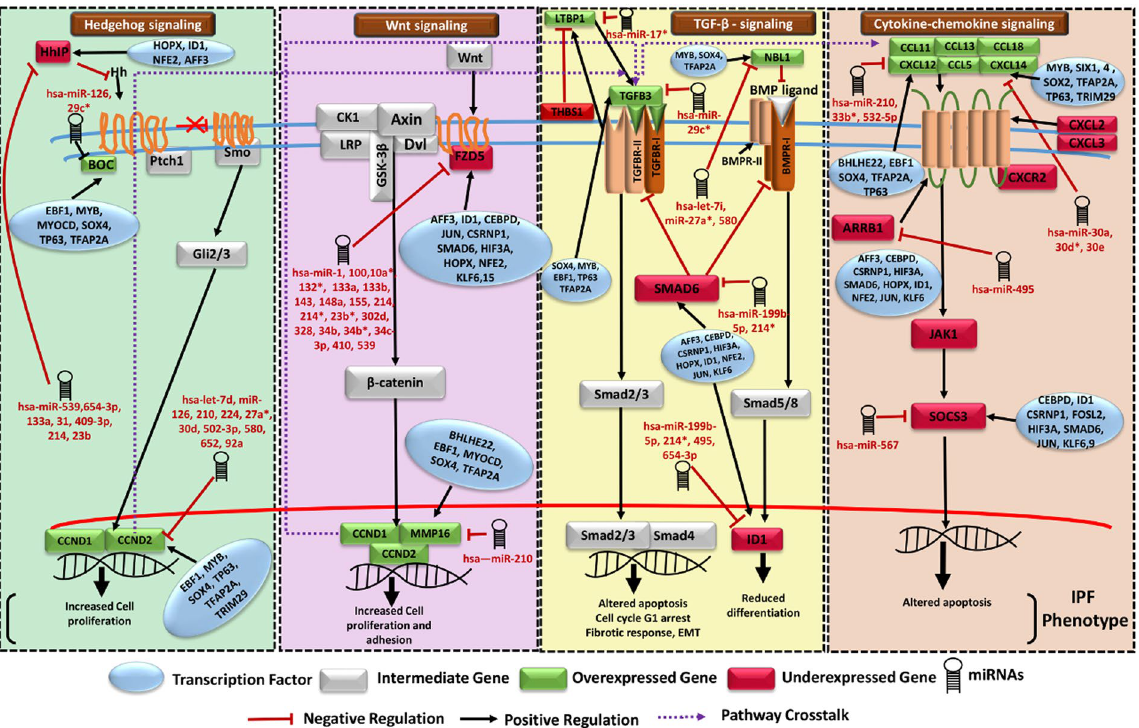
Figure 1. A molecular system model for IPF. It involves four crucial biological pathways (Hedgehog signaling, Wnt signaling, TGF β signaling and Cytokine-chemokine signaling) having cross-talk with each other. The model describes the mechanism and several regulatory components involved in IPF disease mechanism causing increased cell proliferation, adhesion, reduced differentiation, altered apoptosis and epithelial to mesenchymal transition. DEGs Frizzled 5 receptor, LTBP1, HHIP, BOC, CXCL12, CXCL14, ARRB1, NBL1 and SOCS3 appeared critical in